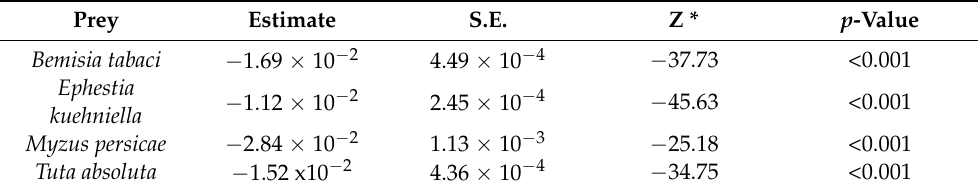
Table 7. Estimates and respective standard error (S.E.) of the linear coefficient of logistic regression analysis of the proportion of prey ( Bemisia tabaci 4th instar nymphs, Ephestia kuehniella eggs, Myzus persicae 1st instar nymphs or Tuta absoluta eggs) consumed by Dicyphus cerastii females in 24 h.